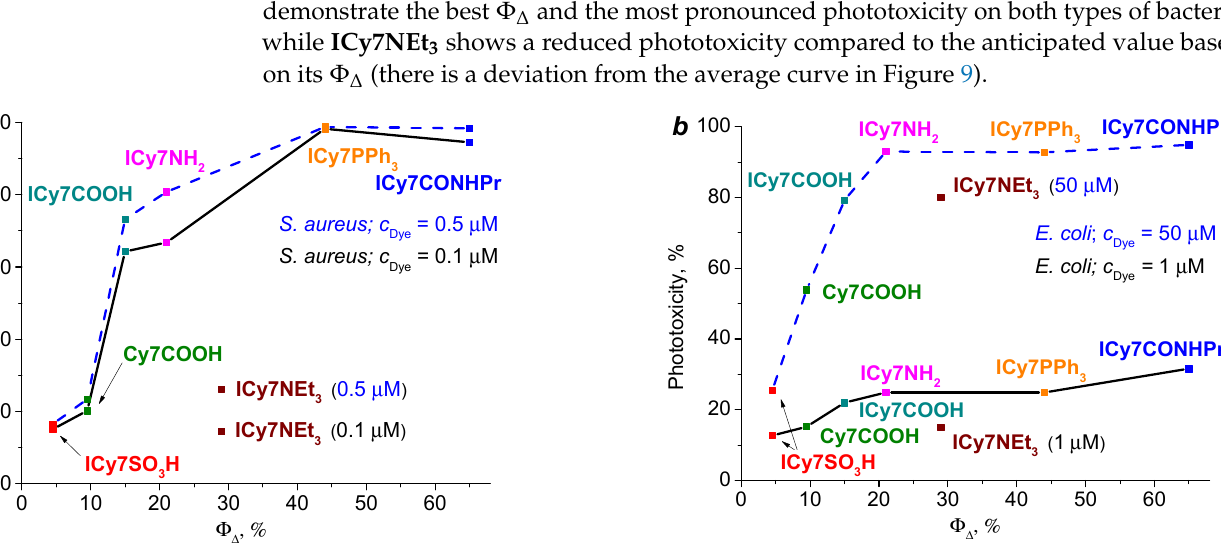
Figure 9. Phototoxicity of the dyes on S. aureus ( a ) and E. coli ( b ) at 3 J/cm 2 and 100 J/cm 2 light doses, respectively, vs. the quantum yield of the singlet oxygen generation ( Φ Δ ) in saline.